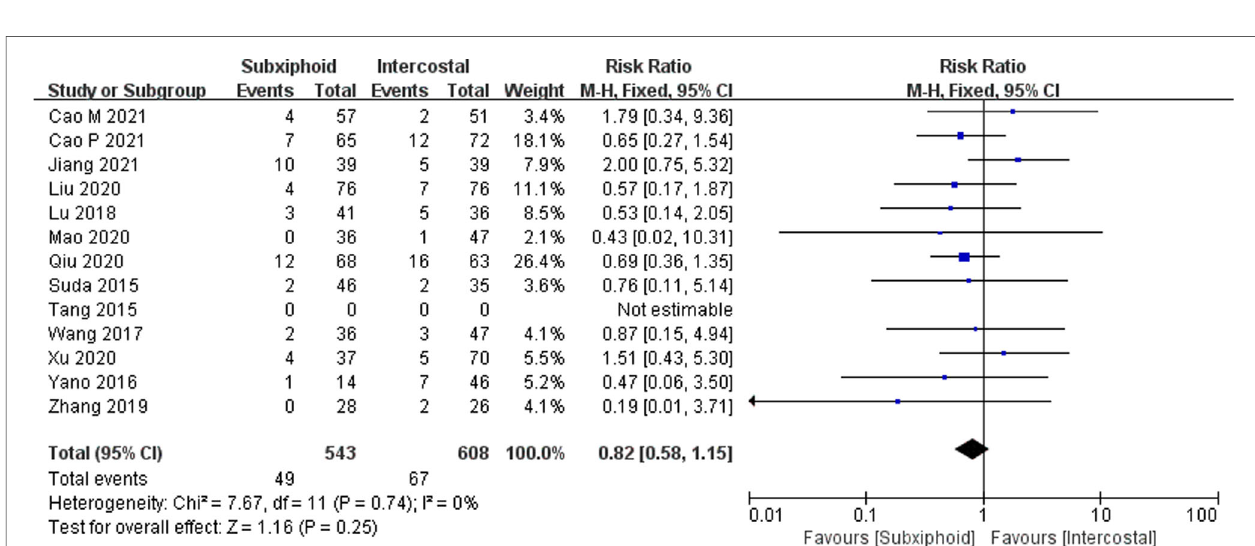
FIGURE 11 | Forest plot of the role of SMD and its 95% CI of VAS score on the seventh day postoperation between SVATS and IVATS groups.